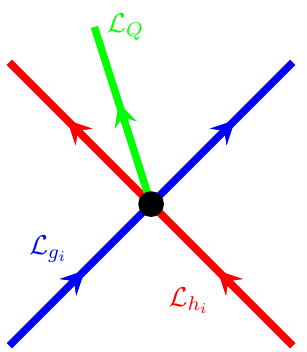
(blue) and a L h i i defect (green). The presence of this L defect can Q Q H A 1 encircling the and L intersection L g γ 1 h i i , L , L defects is g i h i Q